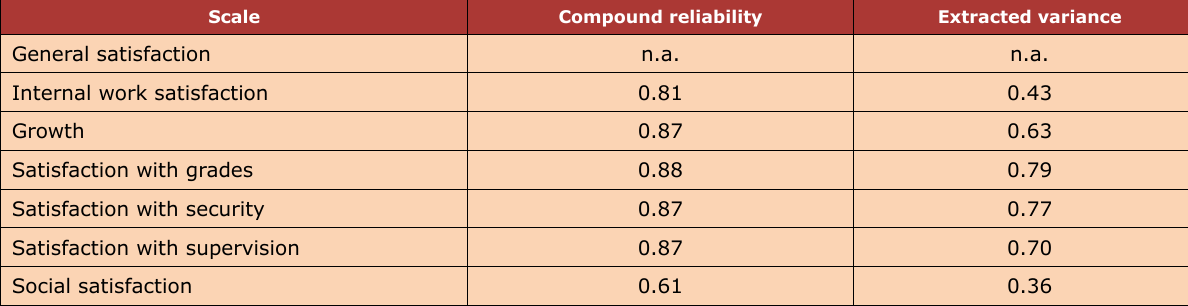
Table 5. compound reliability and extracted variance (n.a.=not available)